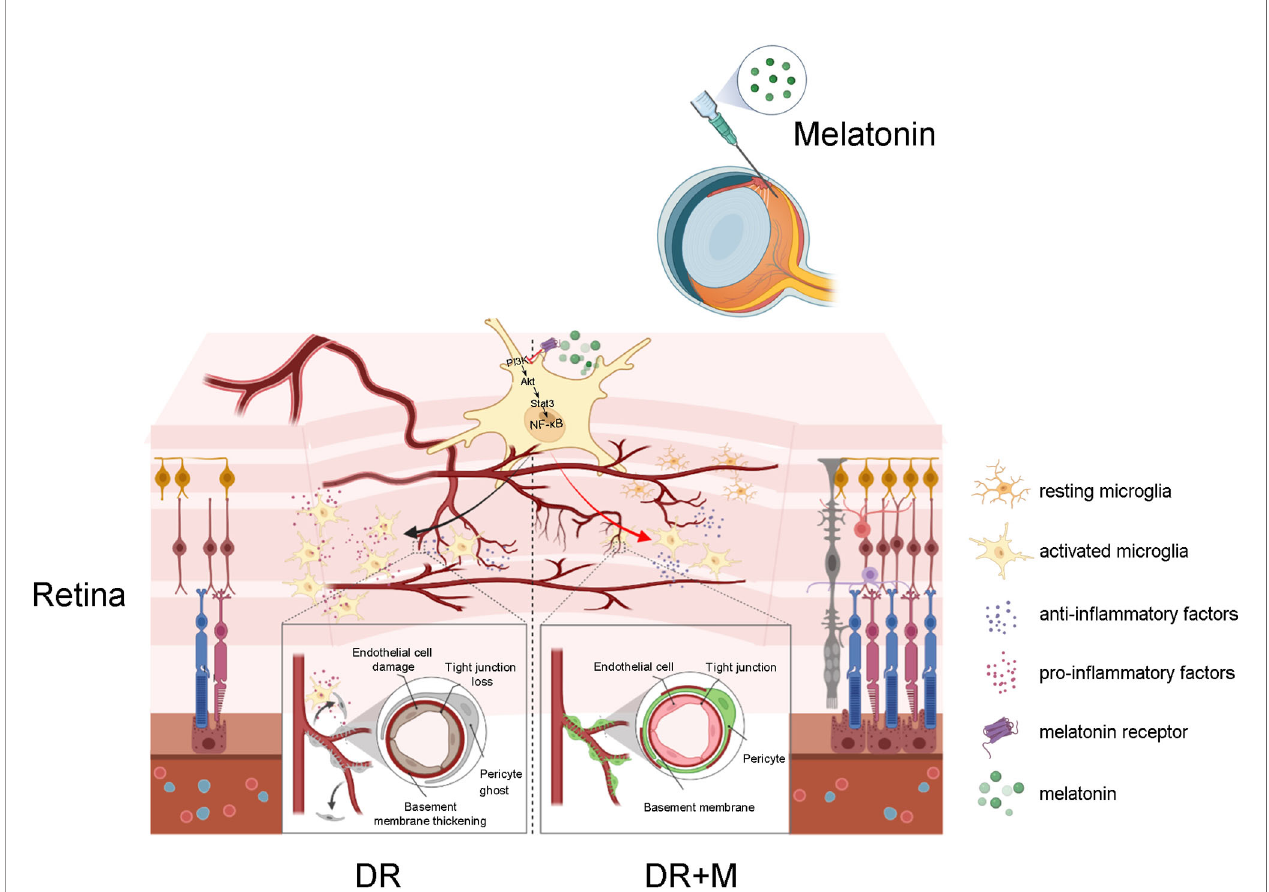
FIGURE 11 | Schematic of the activation of microglia in diabetic retinopathy and the mechanism of melatonin to protect inner blood-retinal barrier by regulating microglia. DR, diabetic retinopathy; DR+M, diabetic retinopathy with melatonin